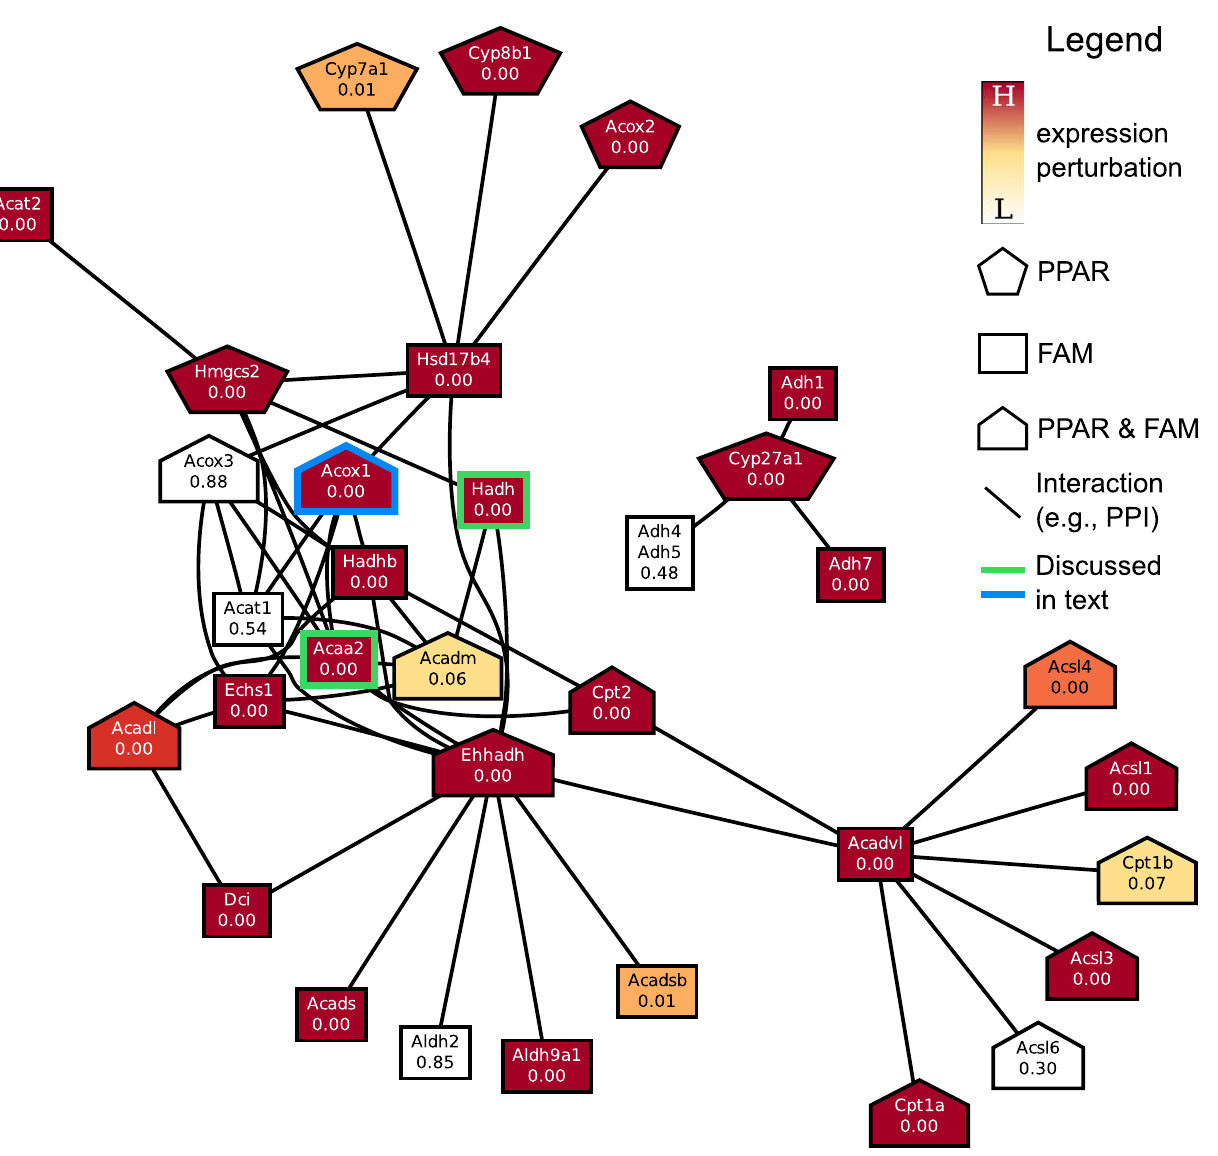
Figure 10. Network of functional interactions resulting in the link between HSA03320_PPAR_SIGNALING_PATHWAY and HSA00071_FATTY_ACID_METABOLISM on day 8. Abbreviations: PPAR: annotated with HSA03320_PPAR_SIGNALING_PATHWAY, FAM: annotated with HSA00071_FATTY_ACID_METABOLISM.